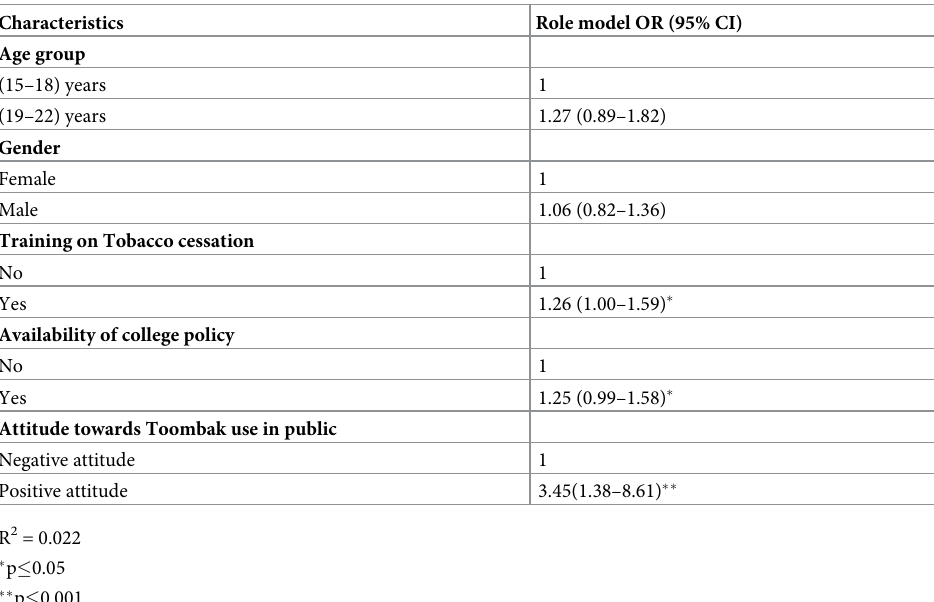
Table 3. Health professions students’ perceived role model status regressed on formal training, availability of col- lege policy, and attitude towards use of Toombak in public (OR,